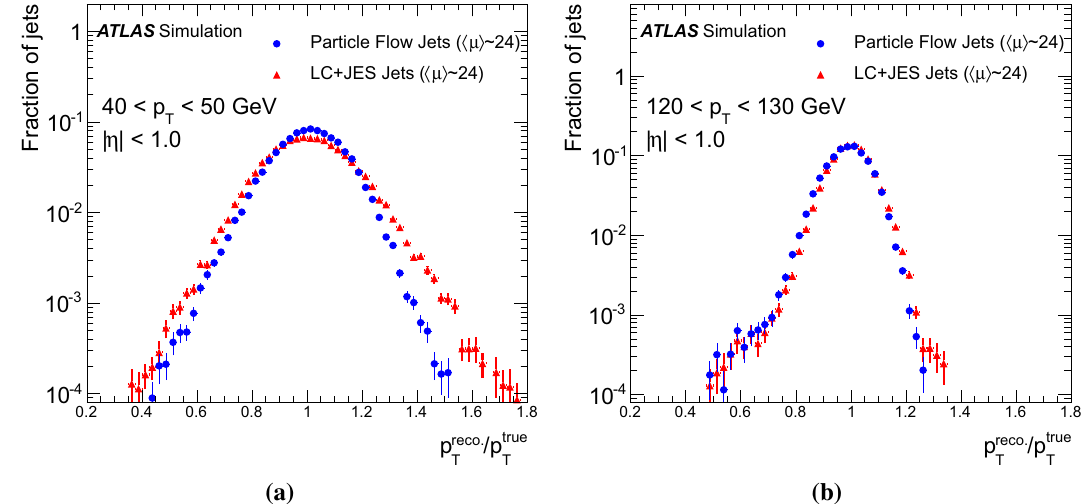
Fig. 27 The jet transverse momentum response distribution as determined in dijet MC events for calorimeter jets and particle flow jets. Two different p T bins are shown; a 40 < p T < 50GeV and b 120 < p T < 130GeV. Simulated pile-up conditions are similar to the data-taking in